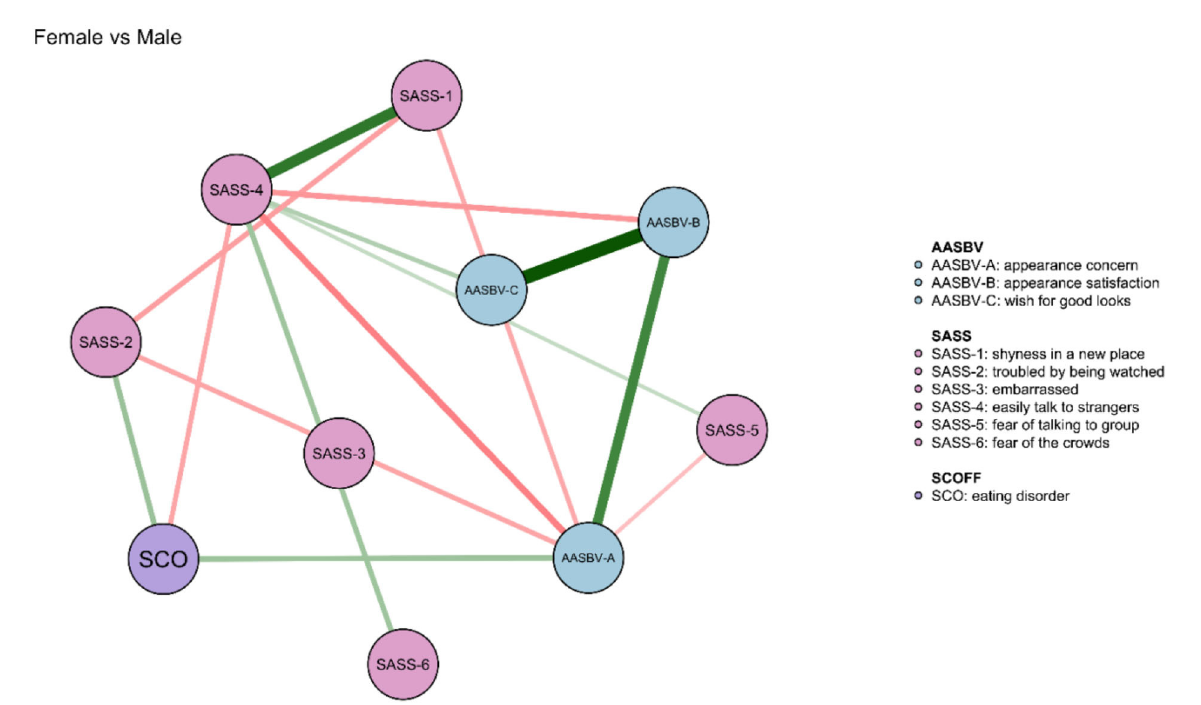
FIGURE4 Comparison of symptom network model between the male and female sample. The green edges denote the stronger connections between symptoms in females when compared with